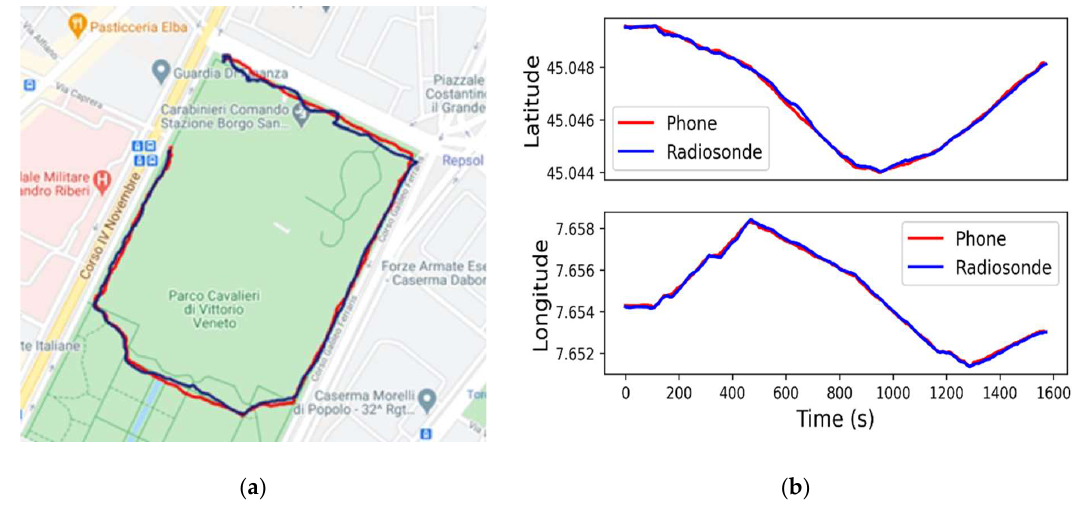
Figure 10. Trajectory recorded by the radioprobe (blue line) and the smartphone GPS logger (red line) during a walk: ( a ) trajectory comparison displayed on a map; ( b ) latitude and longitude comparison between the radioprobe and the smartphone GPS logger in function of time. Table 7. Statistical results of positioning sensor accuracy (internal measurement unit (IMU) and Global Navigation Satellite System (GNSS)) during the experiment.